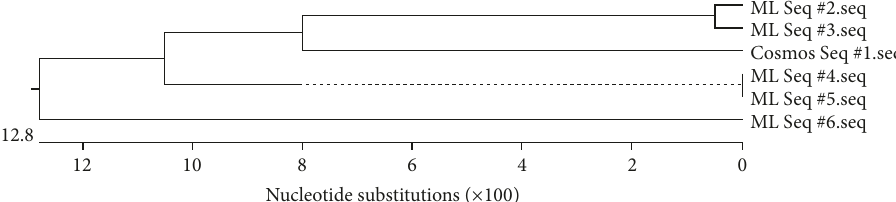
Figure 4: Phylogenetic dendrogram on the basis of the gene fragment obtained with universal primers specific to the Mycobacteria sp. DNA, Cosmos Seq # 1: the nucleotide sequence of a PCR product from the space dust. ML Seq # 2–ML Seq # 6: the nucleotide sequences of PCR products from the samples of sea surface microlayer.